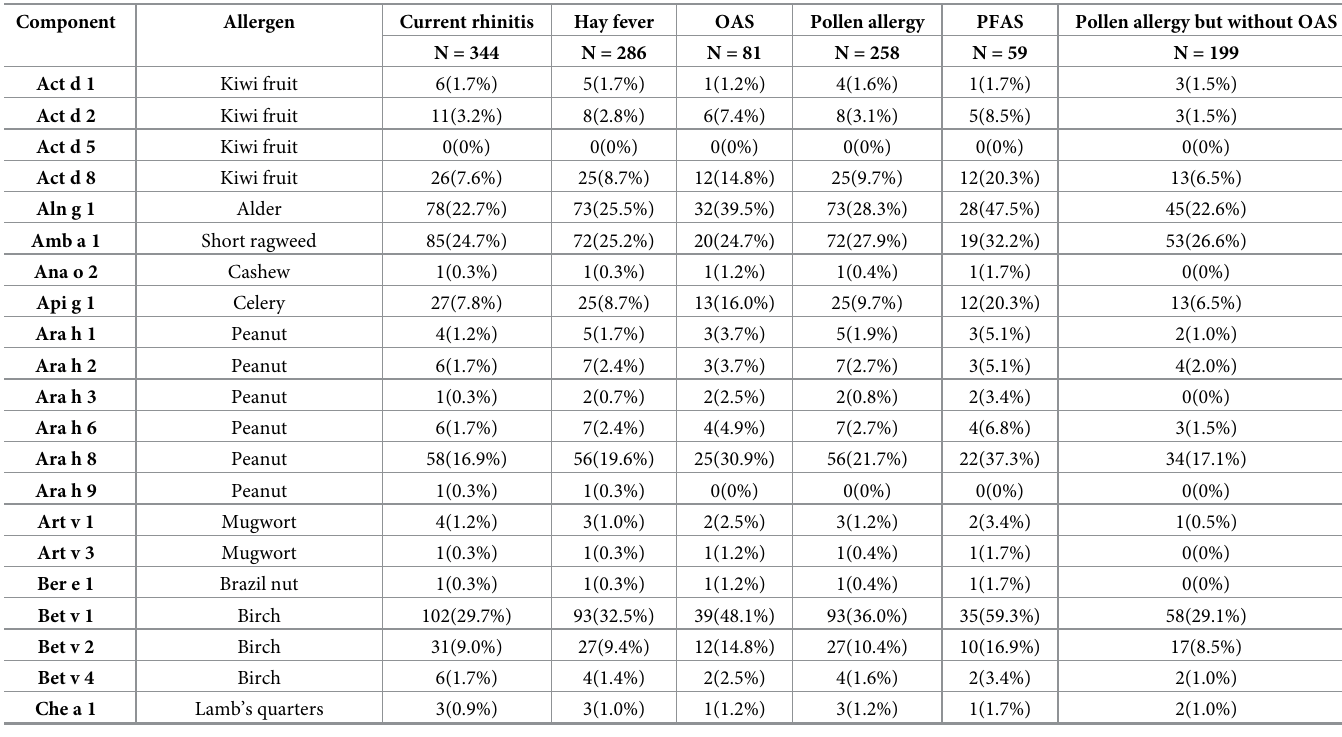
Table 5. All-component sensitization by allergic outcomes at 13 years